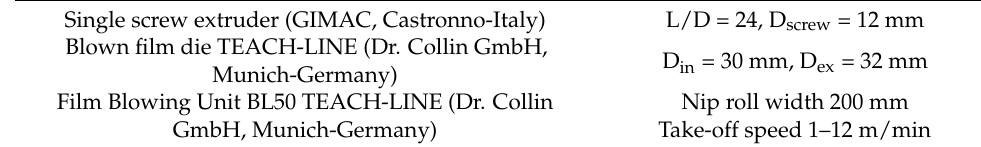
D in = 30 mm, D ex = 32 mm Nip roll width 200 mm Take-off speed 1–12